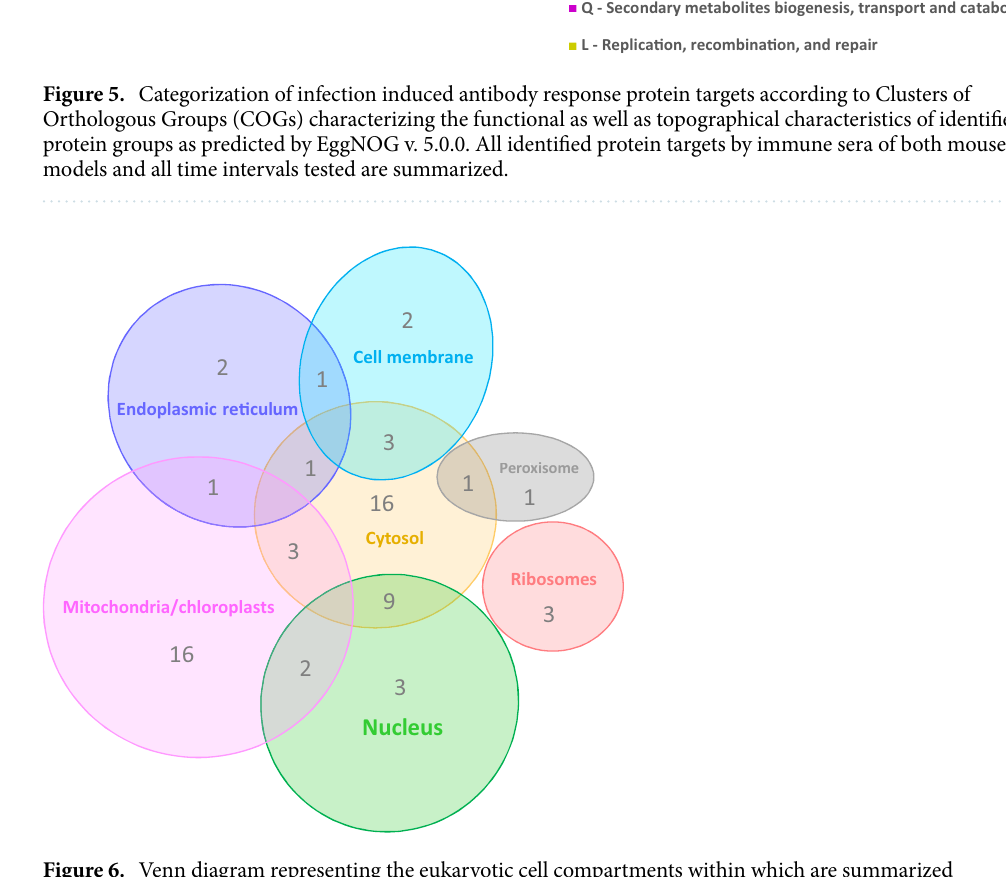
Figure 6. Venn diagram representing the eukaryotic cell compartments within which are summarized orthologs or analogs of all F. tularensis proteins reactive with early infection-induced antibody clones. The numbers within sectors represent a set of proteins located at a given cellular compartment. Data on cell localization were taken from the UniProtKB